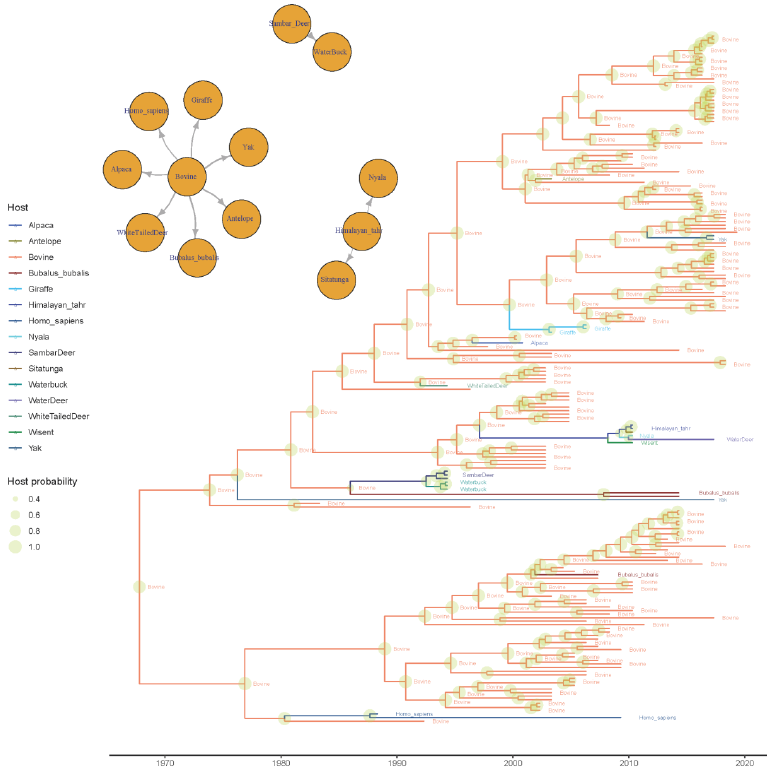
Figure 6. Time-scaled phylogenetic tree based on BoCV spike protein. The estimated ancestral host has been color-coded, while its posterior probability is depicted as a circle on the corresponding node, whose size is proportional to the estimated value. The statistically supported migration routes have been represented in the upper left insert.